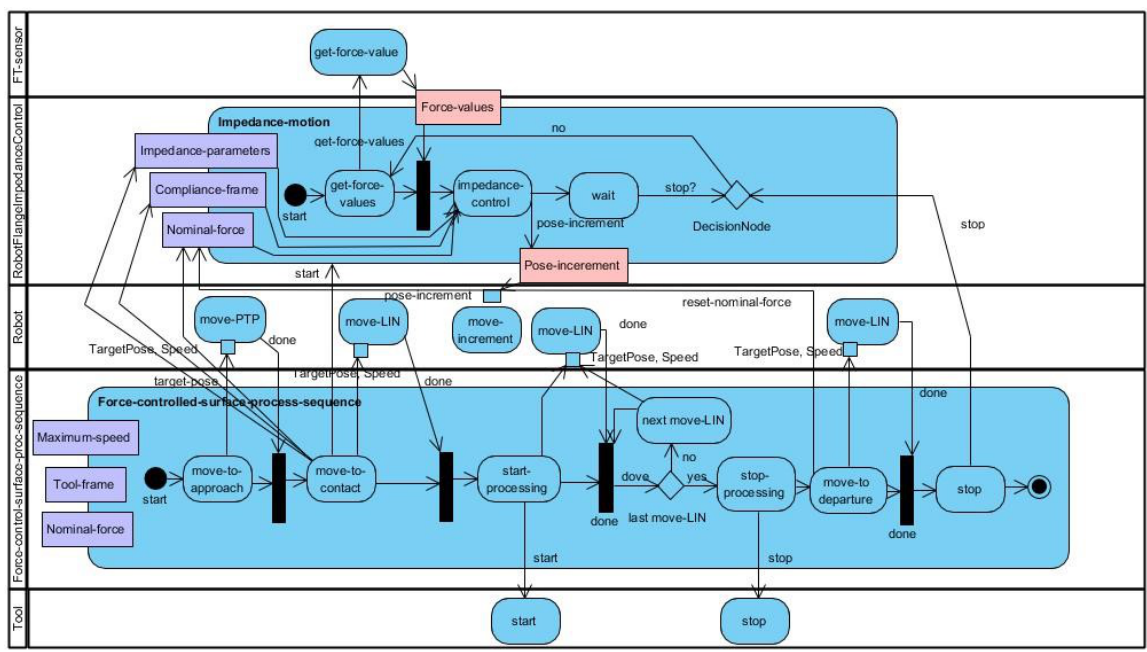
Figure 2: Compound skill: grinding of an object feature, like plane or edge, with contact to followed object surfaces